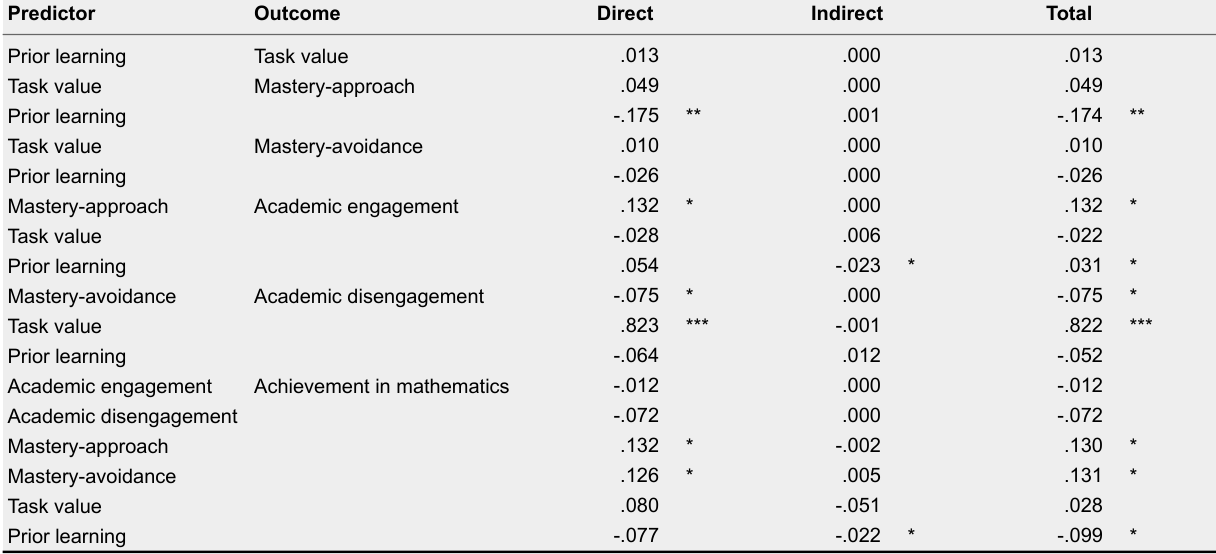
Decomposition of Effects: Direct, Indirect, and